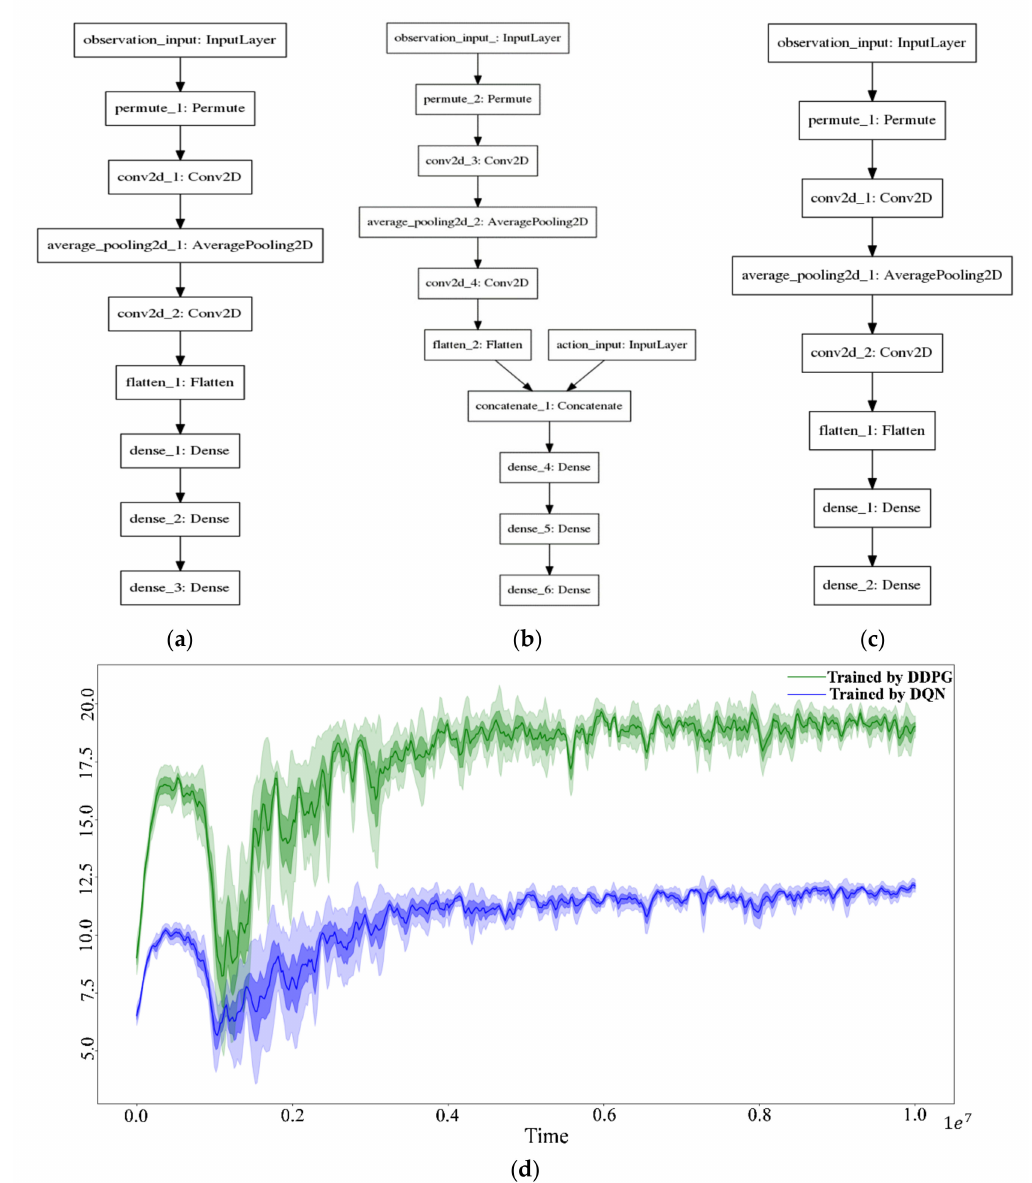
Figure 5. ( a ) The structure of the actor-network. ( b ) The structure of the critic network. ( c ) The structure of the Q-network. ( d ) Reward change of the ACSLA during the training